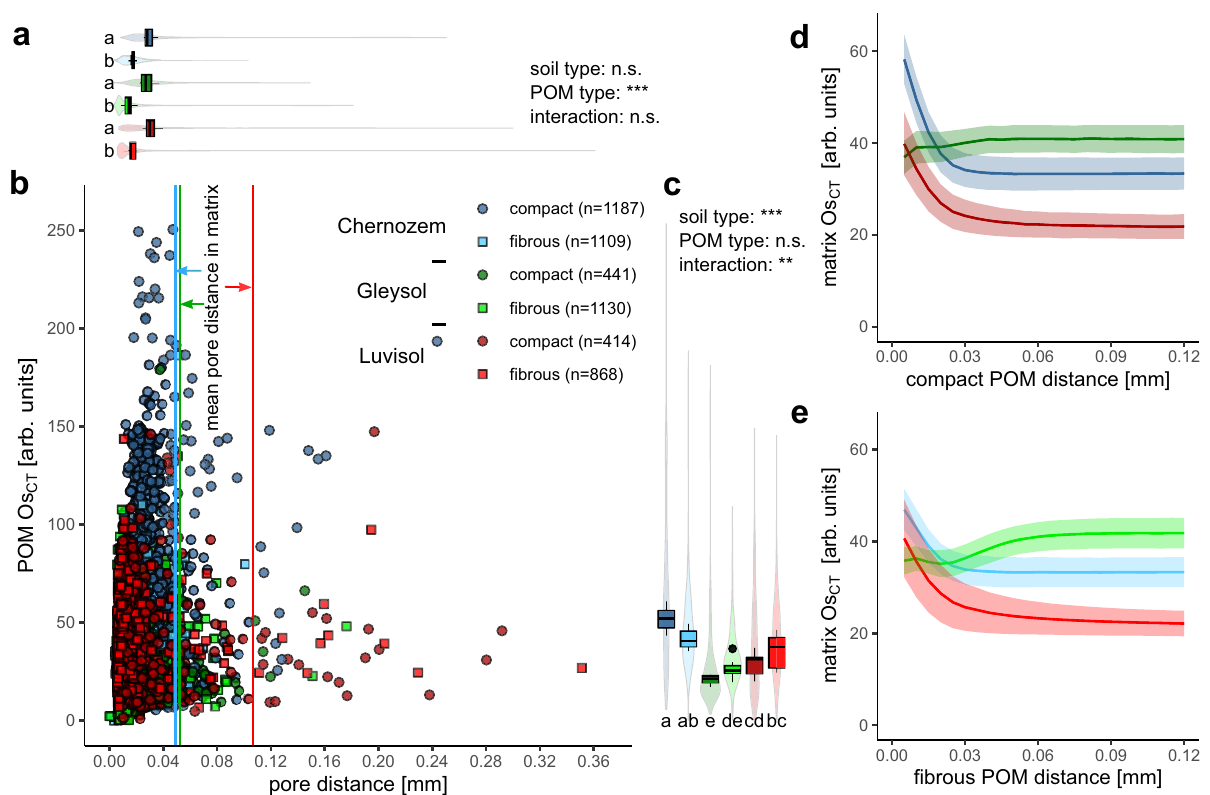
Fig. 6 Characterization of fi brous and compact particulate organic matter in different soils. b Average Os concentration (Os CT ) and average pore distance for individual, fi brous, or compact POM objects. a and c Violin plots represent marginal distributions of individual POM objects. Boxplots represent the 0%, 25%, 50%, 75, and 100% percentiles of averages for individual aggregates ( n = 8) with small letters re fl ecting signi fi cant differences tested at p < 0.05 (n.s. not signi fi cant). d and e Average Os concentration in the soil matrix around compact and fi brous POM. Shaded areas represent two standard errors in each direction ( n =